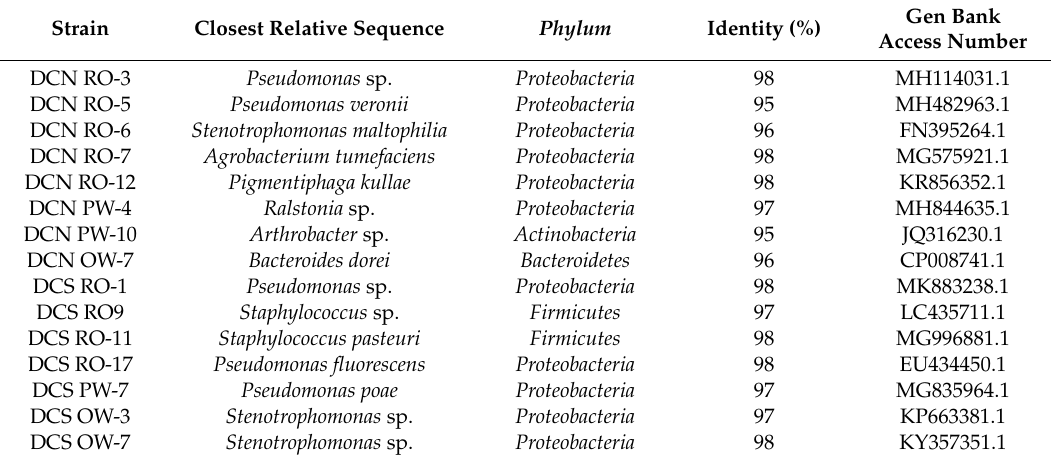
Table 1. Identification of heterotrophic bacterial strains isolated from both haemodialysis centres.